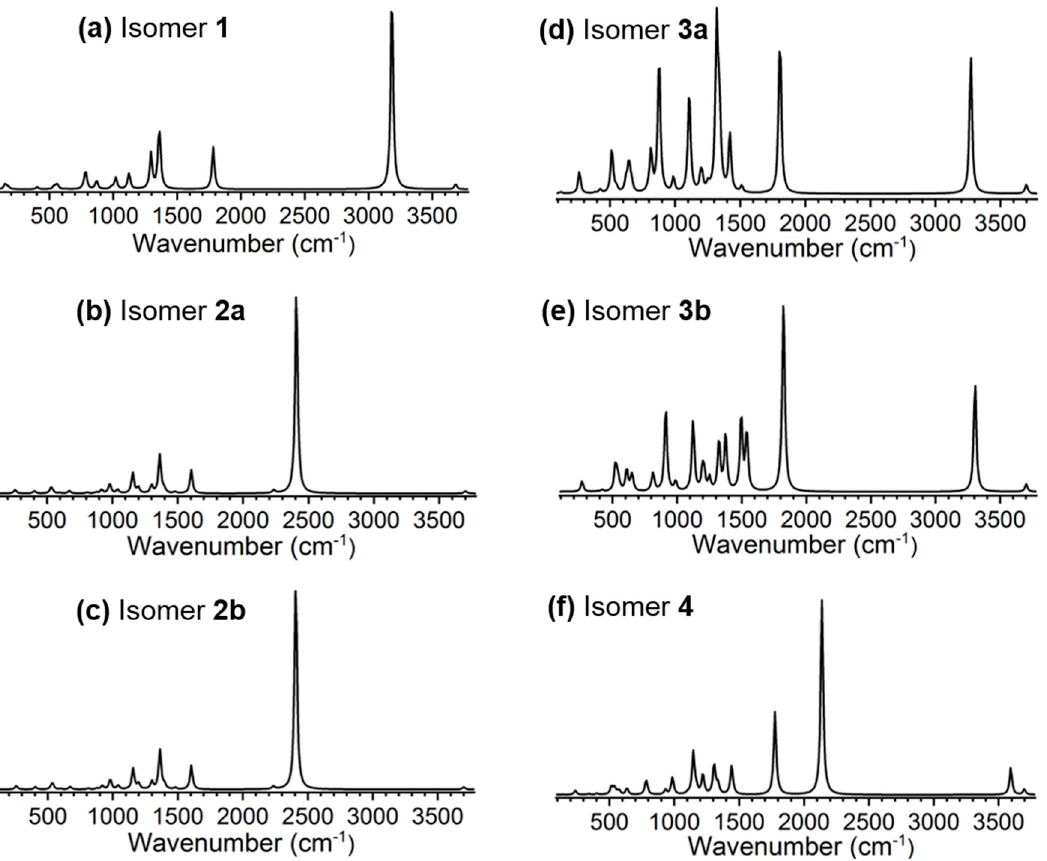
Figure 4. Simulated harmonic infrared spectra of the six isomers ( a – f ) of [H 2 CO 3 ·HSO 4 ] – at M06-2X/aug-cc-pVTZ level of theory. The calculated vibrational frequencies have been broadened using Gaussian line shape of 12 cm − 1 full width half maximum, and a scaling factor of 0.956 [55] has been applied.